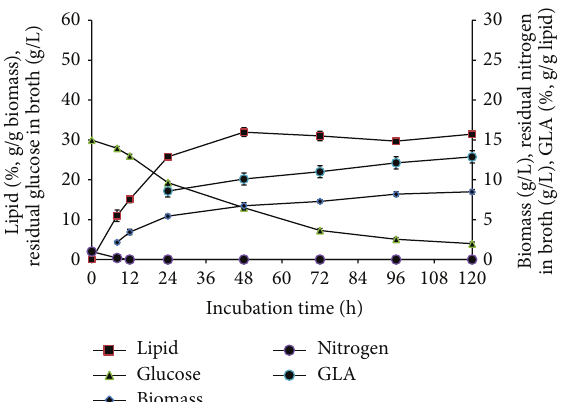
Figure 1: Profile of growth and lipid accumulation of C. bainieri 2A1. The culture was cultivated in 500 mL shake flask containing 200 mL of nitrogen-limited medium at 30 ∘ C, 200 rpm, and starting inoculums of 10% (v/v). The data represent means ± SDs, 𝑛 = 3 .